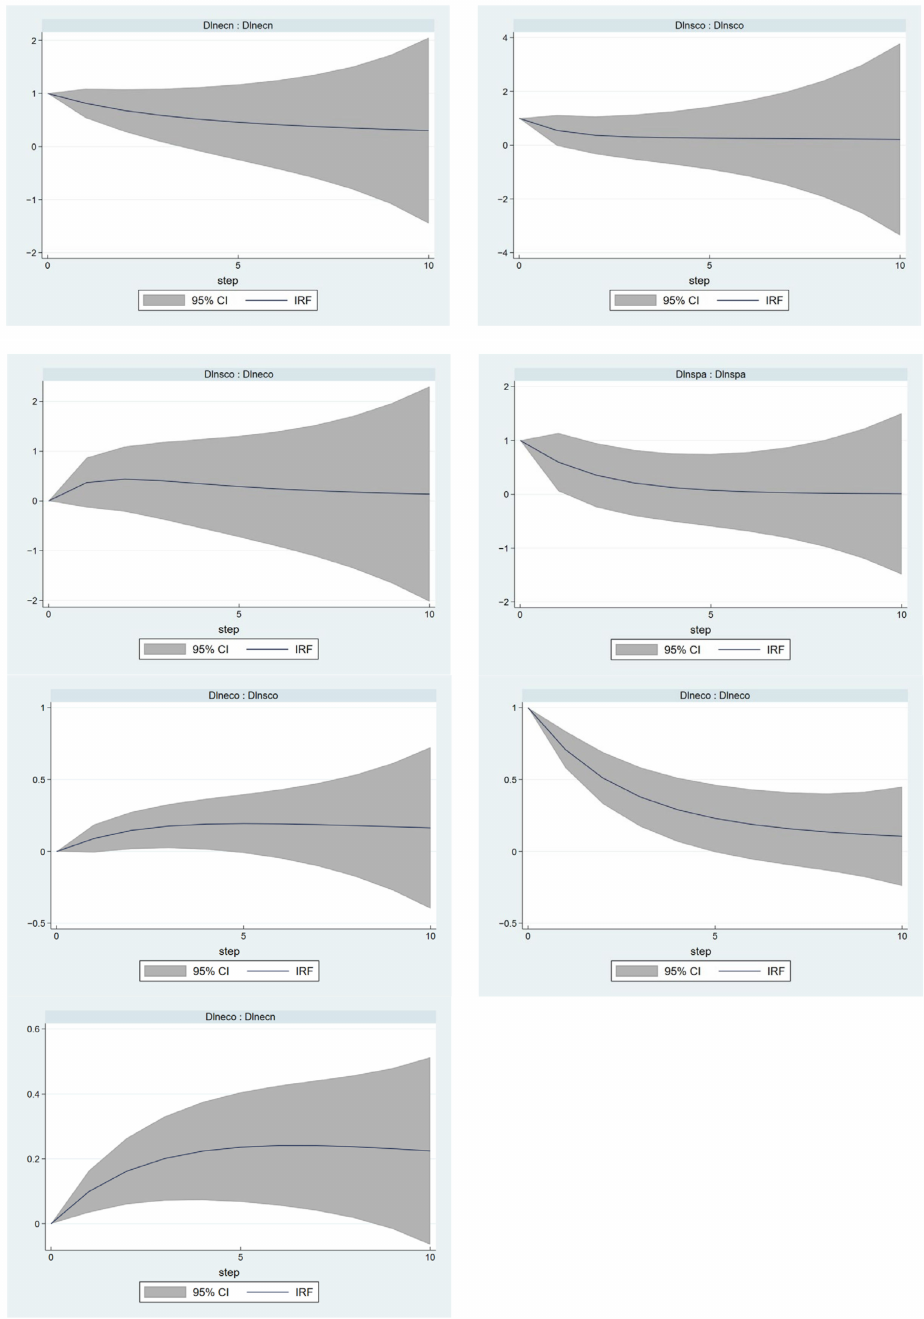
Figure 7. Impulse response diagram for each dimension of urban-rural integration in the Yangtze River